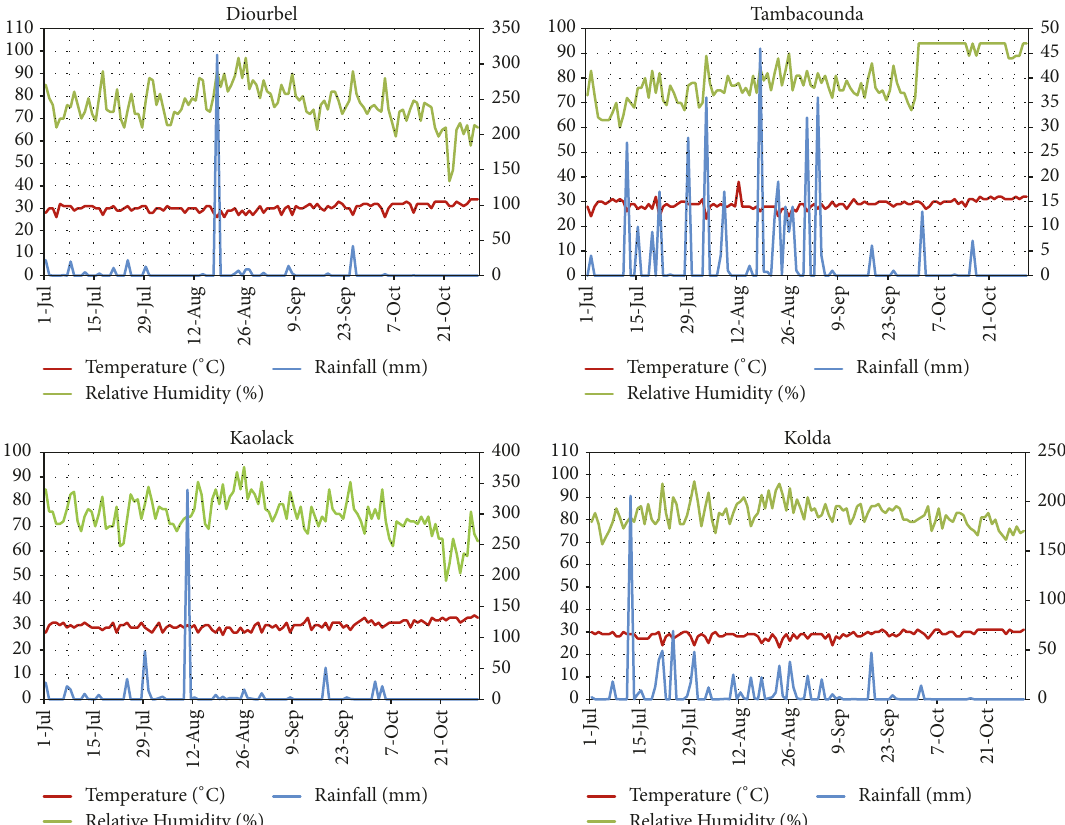
Figure 3: Daily temperature, relative humidity (both at left-side of the Y-axis), and rainfall (right-side of the Y-axis) in Diourbel, Tambacounda, Kolda, and Kaolack during rainy season